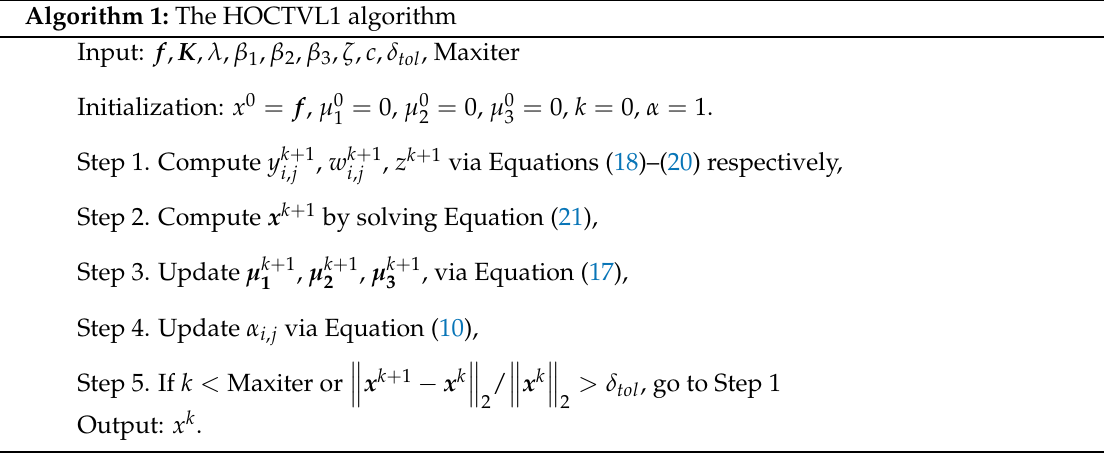
Algorithm 1: The HOCTVL1